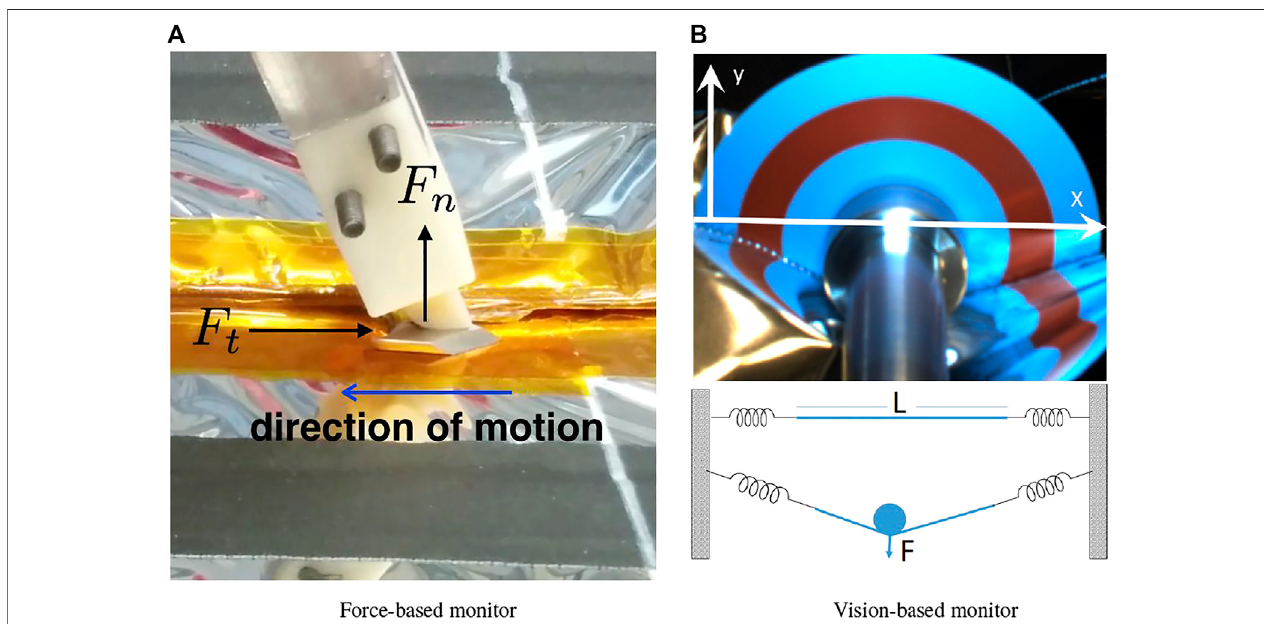
FIGURE 6 | Two strategies for monitoring cutting performance: (A) force-based and (B) vision-based, with 2D sketch of model on bottom.